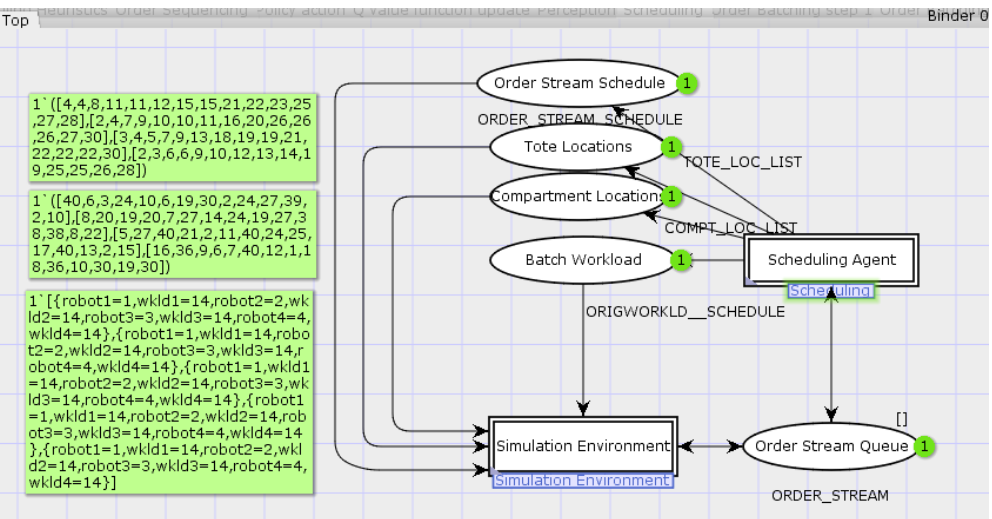
Figure 14. The number of agent visits to each state for the scheduling of one batch of 28 orders and four emergency orders, with mean order size four line items per order. The agent followed an ε-greedy policy with ε = 0.2.